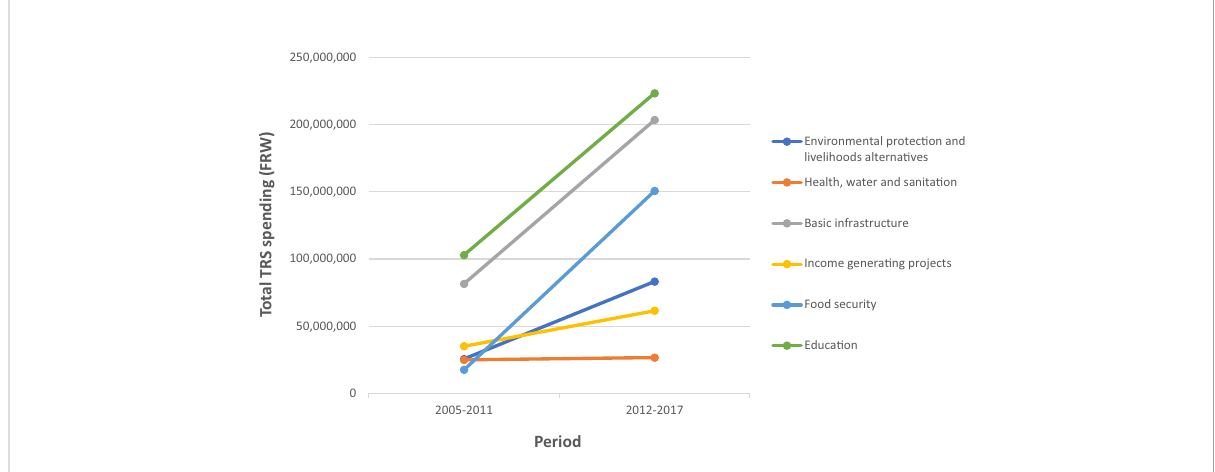
FIGURE 2 Tourism revenue sharing funding allocation per project type, demonstrating increases between periods 2005-2011 and 2012-2017. There was no project supported in 2011. TRS, tourism revenue sharing; FRW, Franc Rwandais. Data source: Rwanda Development